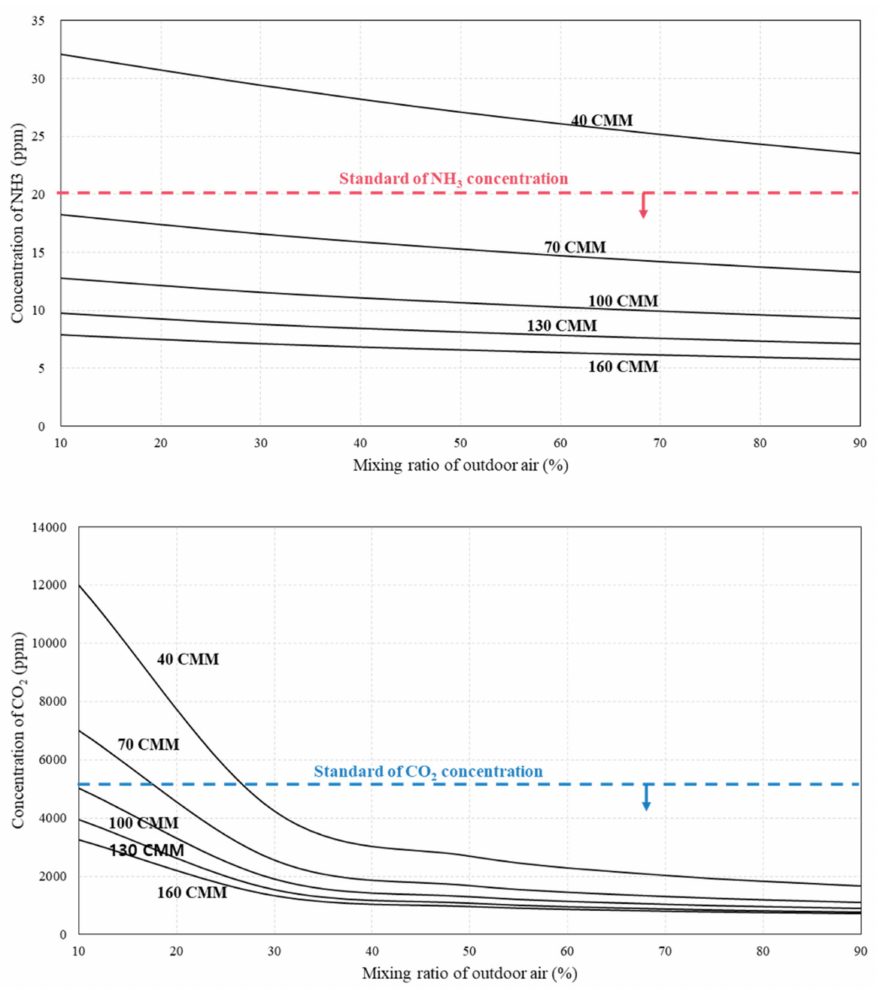
Figure 8. Computed results of the numerical model according to the ventilation rate and outdoor air mixing